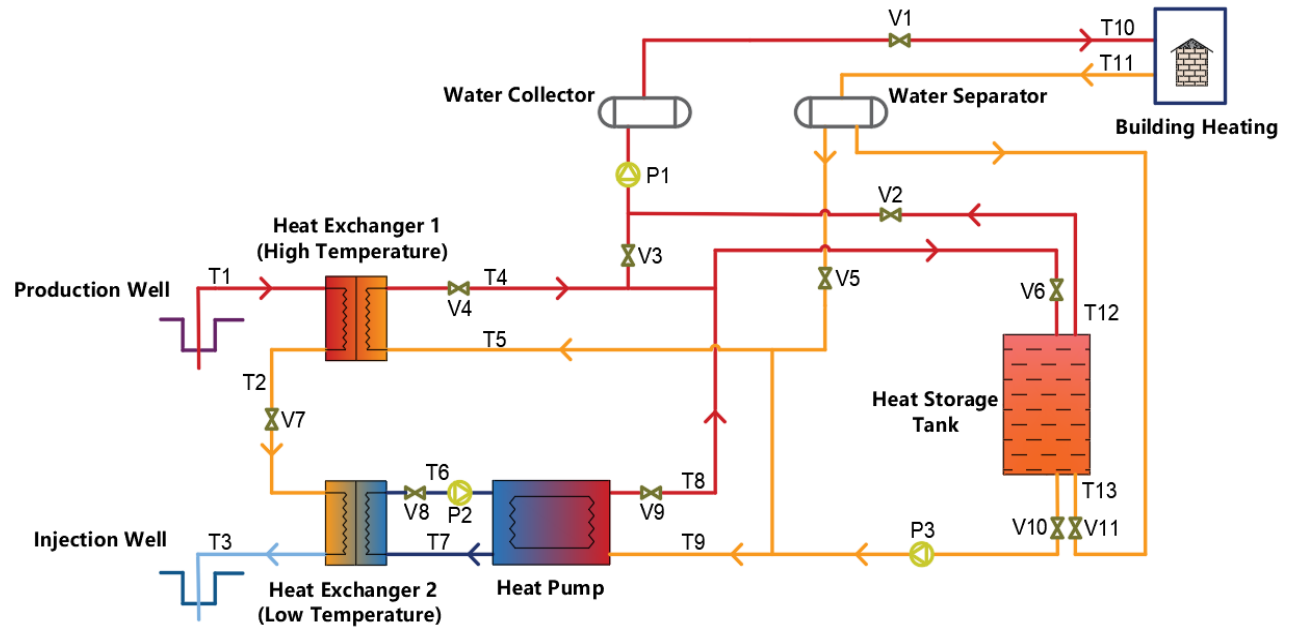
Figure 7. Energy storage–geothermal coupled heating system for Case 3 and Case 4.